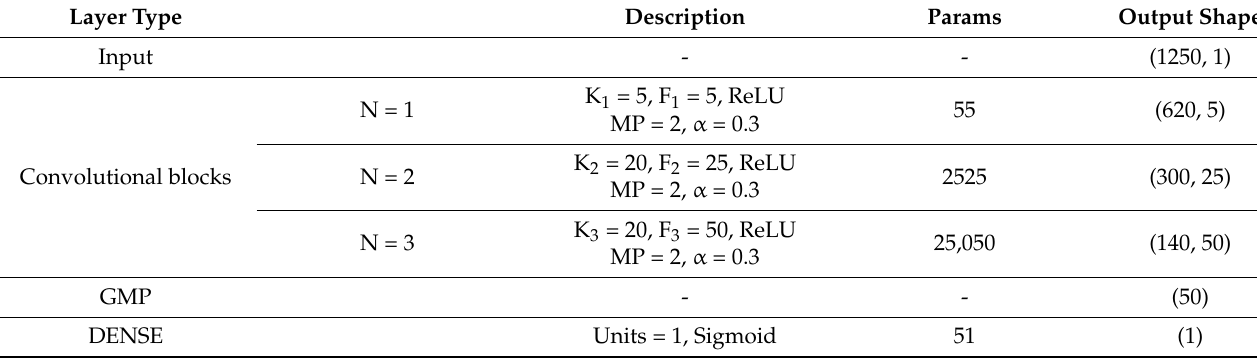
Table 4. Details of CNN3-CC-ECG network for analysis of ECG signals during CPR.